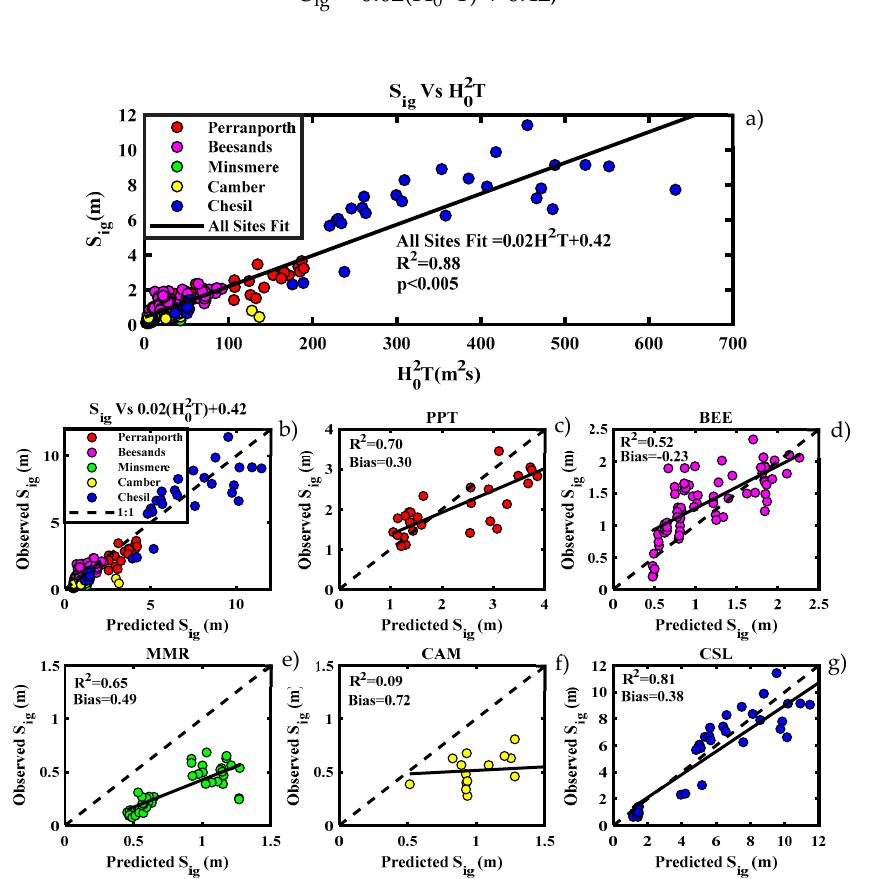
Figure 9. ( a ) Significant infragravity swash height S ig against H 02 T. Linear best fit for all sites (Equation (6)), black line. ( b ) Comparison of S ig heights observed and those predicted by Equation (6) at all sites. ( c – g ) As above, but for individual sites. Equation (6) is only valid for high-energy conditions.